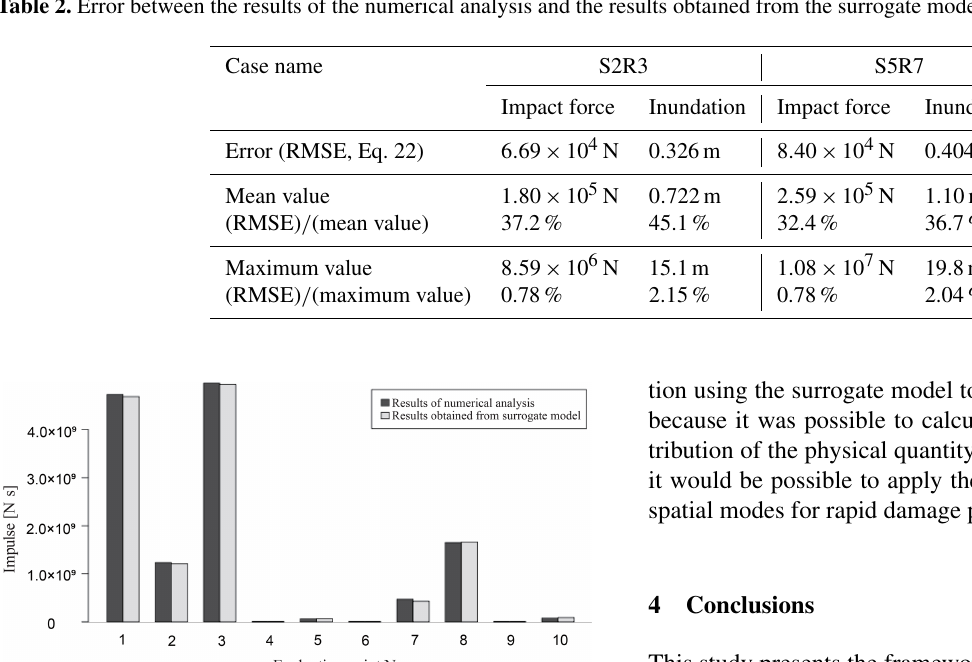
Table 2. Error between the results of the numerical analysis and the results obtained from the surrogate models.